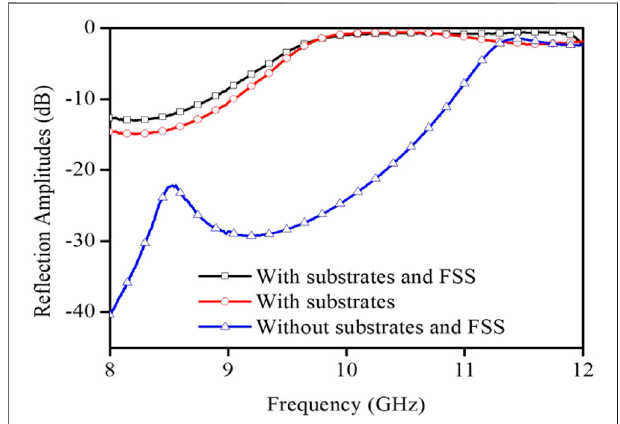
FIGURE 3 | Re fl ection amplitudes with or without substrates and an